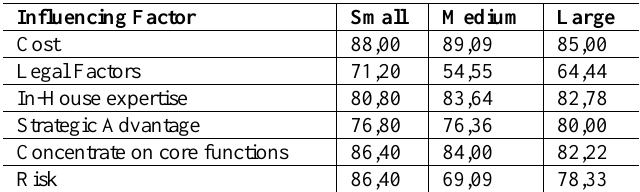
Table 5: The extent to which the different